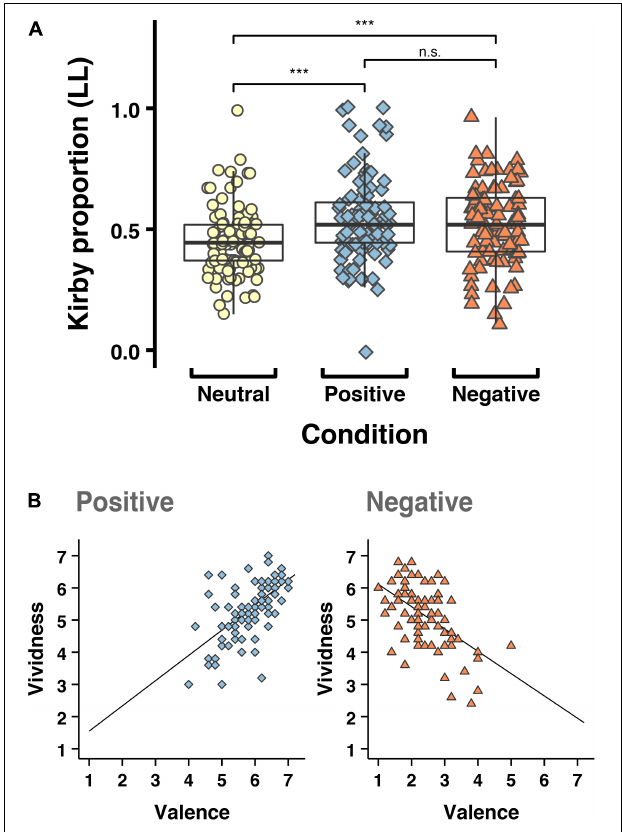
FIGURE 1 | A role for cued prospection in adaptive intertemporal choice? (A) From a between-participants study with 297 participants: The mean proportion of larger, later (rather than smaller, sooner) rewards chosen in the Kirby monetary intertemporal choice task when participants were cued with neutral mental imagery (e.g., folding up paper), positive episodic future events (e.g., spending time in nature in 1 week), and negative episodic future events (e.g., getting food poisoning in 1 week). Imagining the future was associated with reduced delay discounting regardless of the valence. ∗∗∗ = Significant at p < 0.001. (B) In the same study, ratings of the event cues demonstrated strong correlations between the vividness with which events were imagined and the emotional impact of those events (valence: 1–7, low scores equate to negative valence and high scores equate to positive valence), illustrating the close ties between episodic mental simulation and emotion. Positive r = 0.62, negative r = − 0.54, p ’s < 0.001. Figure from Bulley et al.